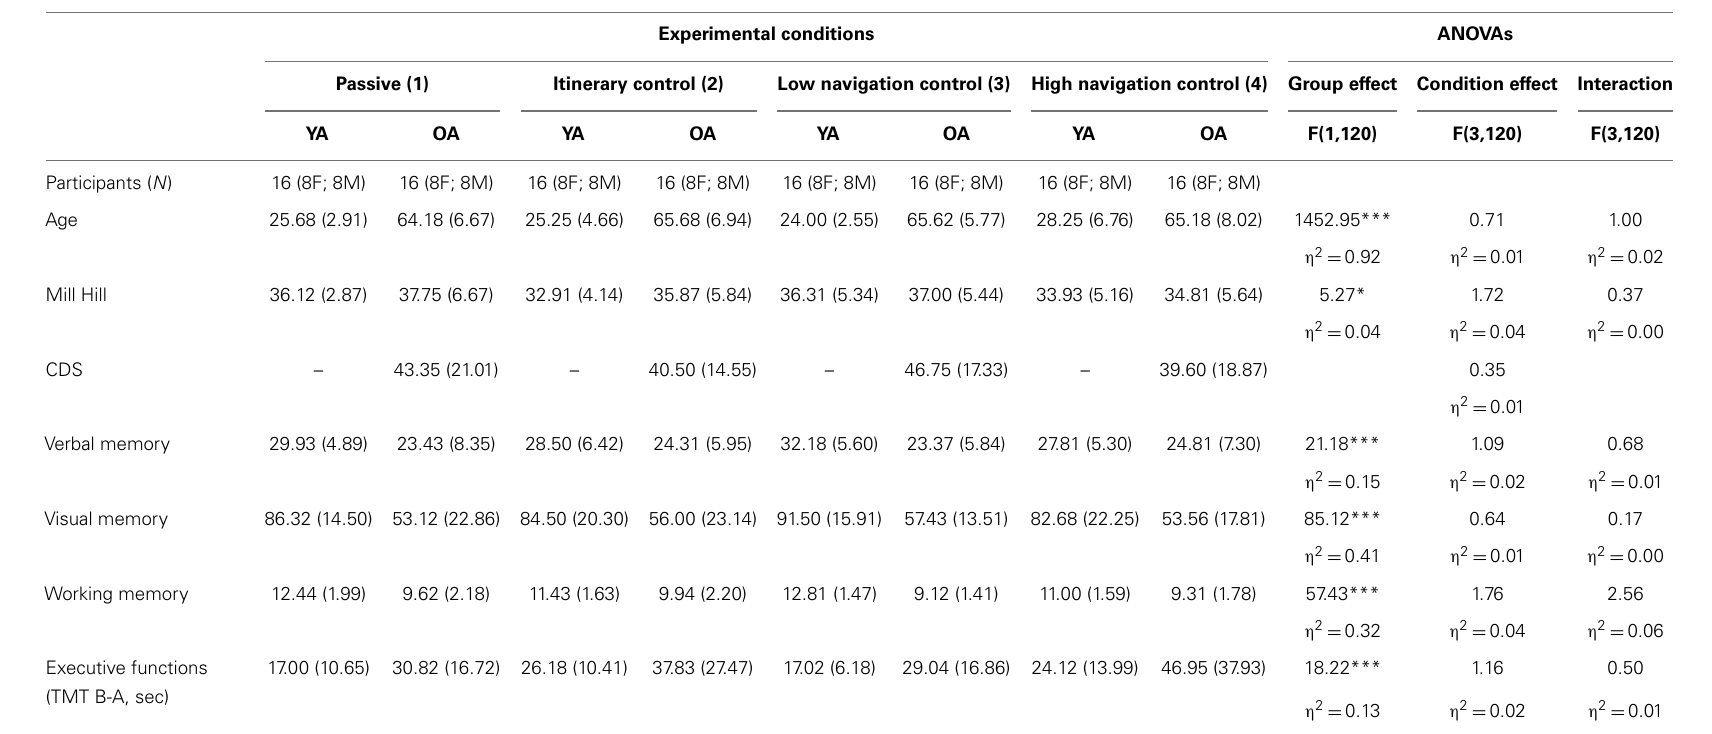
Table 1 | Description of the population as a function of age and experimental condition